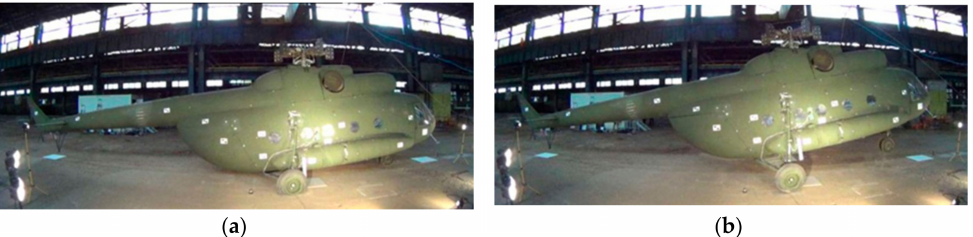
Figure 2. Experimental activity. Helicopter during: maximum strut compression ( a ) and front-wheel spring back ( b